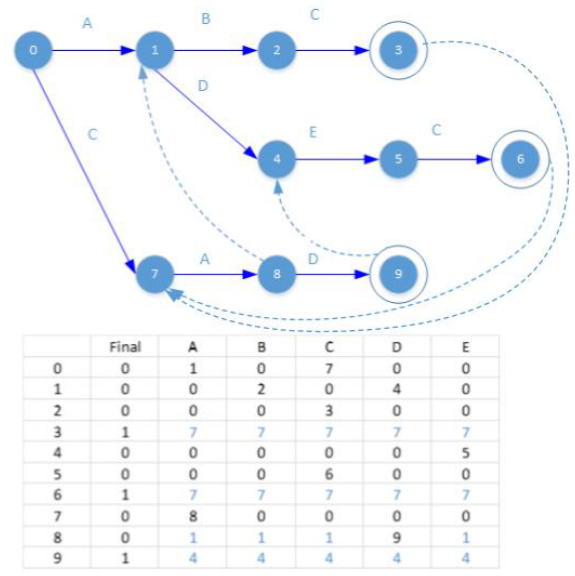
Figure 1: Aho-Corasick State machine and transition table for finding key-words: ABC, ADEC,